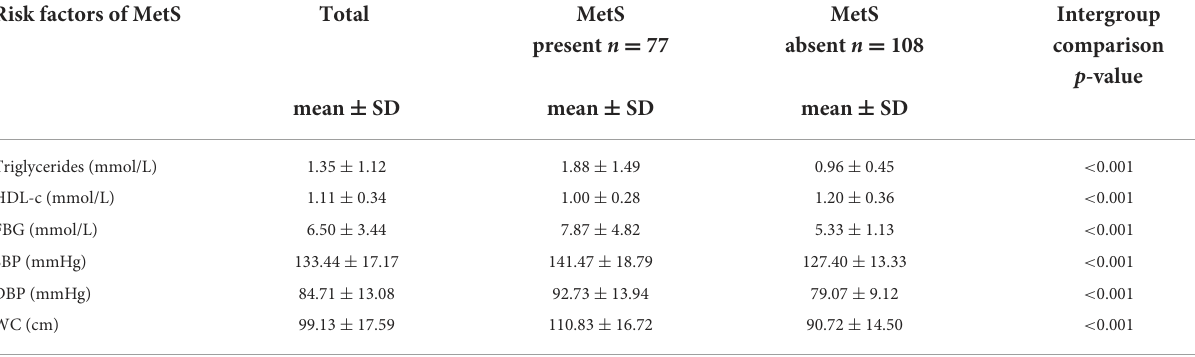
TABLE 2 Mean non-communicable disease risk factors by the presence/absence of MetS. Risk factors of MetS